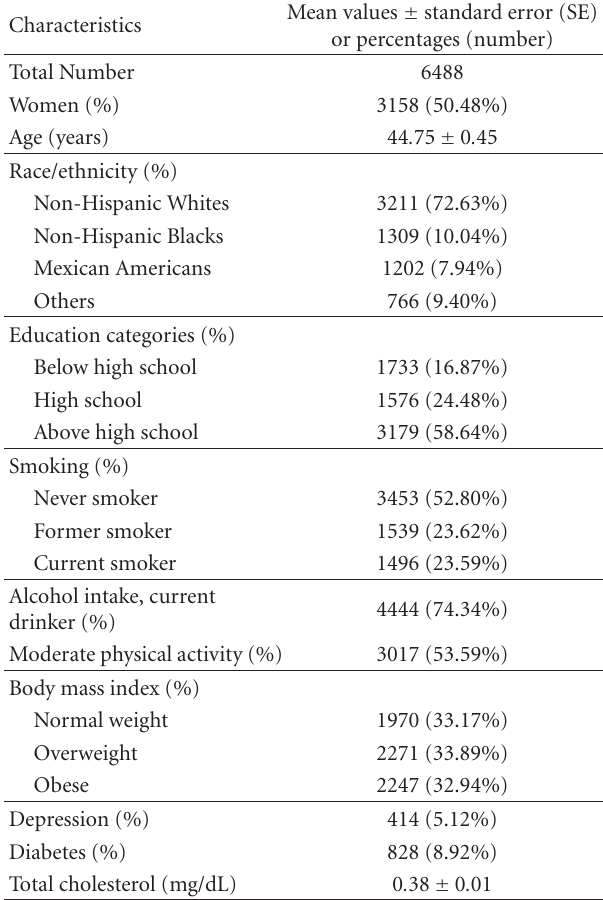
Table 1: Baseline characteristics of the study